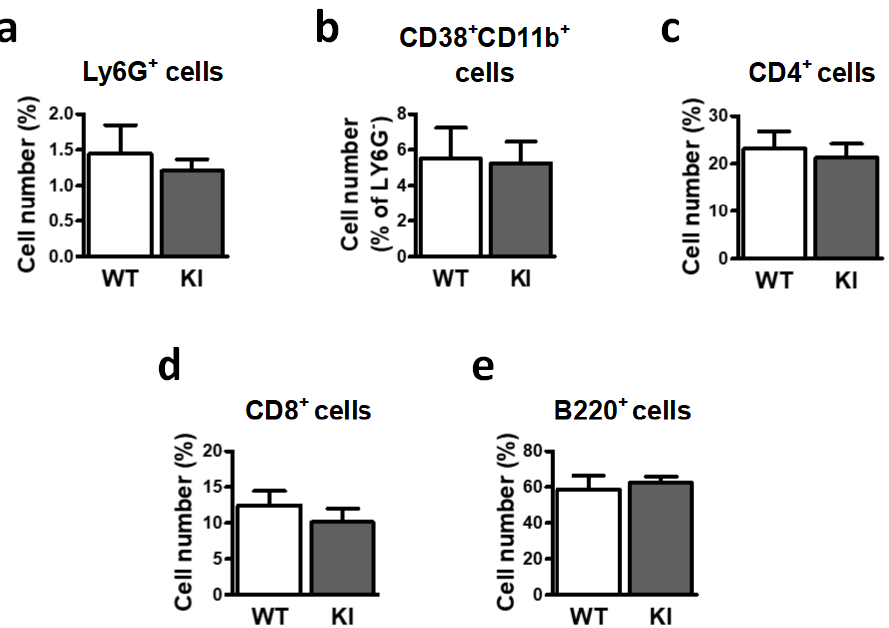
Figure 2. Flow cytometry analysis shows similar spleen cell populations in WT and GSK3 β Ser 389 KI mice. After dissociation of spleen cells, flow cytometry was used to assess the number of ( a) Ly6G + neutrophils, ( b ) CD38 + CD11b + monocytes/macrophages, ( c ) CD4 + cells, ( d ) CD8 + cells, and ( e ) B220 + cells. Histograms show cell numbers expressed as percentage of total cells. Data correspond to mean ± S.E.M. ( n = 5-7). Student t -test was applied to compare genotypes. WT, wild- type; KI, GSK3β Ser 389 knockin.